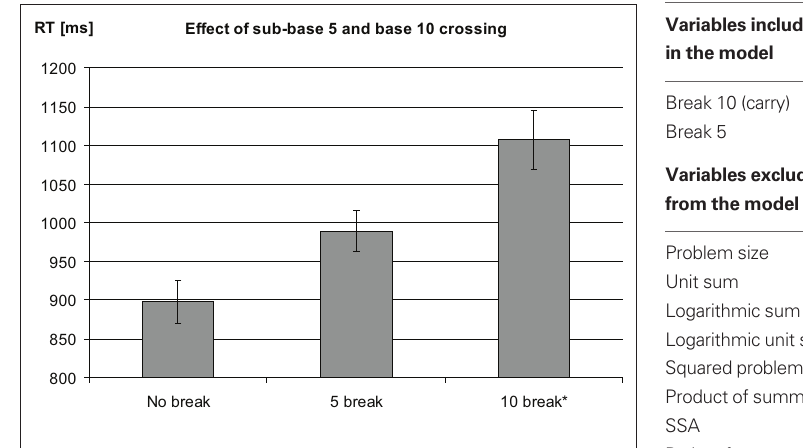
Figure 1 | response latencies for addition problems with and without 5 break as well as for problems with 10 break (carry). Error bars depict 1 standard error of the mean (SEM). *Please note that problems with a 10 break could not be fully matched regarding the units of the result with the two other groups (problems with and without 5 break).